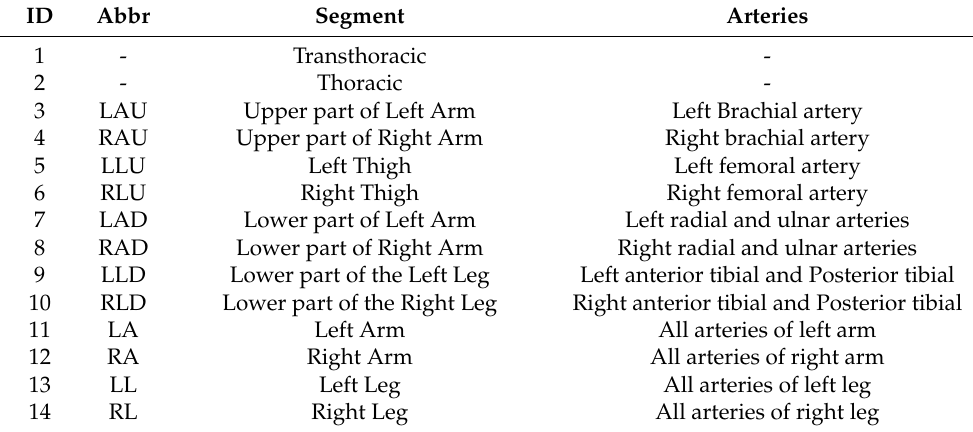
Figure 2. Used channels and placement of electrodes (1-Transthoracic, 2-Thoracic, 3-upper part of left arm (LAU), 4-upper part of right arm (RAU), 5-left thigh (LLU), 6-right thigh (RLU), 7-lower part of left arm (LAD), 8-lower part of right arm (RAD), 9-lower part of the left leg (LLD), 10-lower part of the right leg (RLD), 11-left arm (LA), 12-right arm (RA), 13-right leg (RL), 14-left leg (LL)). Table 1. Information about the recorded signals. Index of the signal (ID), its abbreviation(Abbr), segment of the body from which the signal was recorded (Segment) and main arteries in this segment